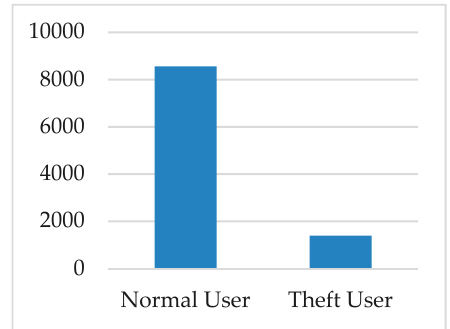
Figure 3. Distribution of normal and theft users in the dataset .